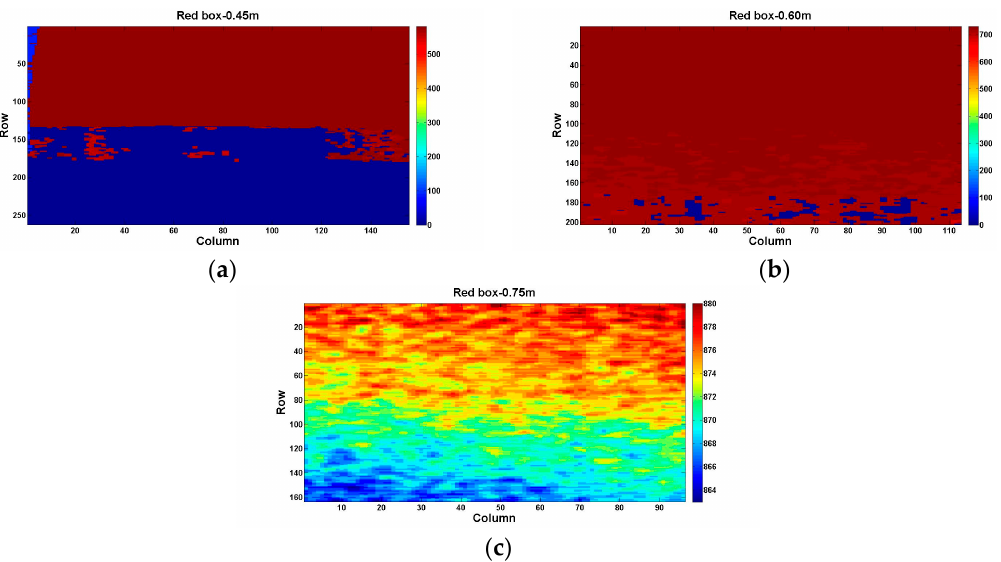
Figure 6. Visualized depth images of the red box region at different distances (front view): ( a ) 0.45 m; ( b ) 0.60 m; and ( c ) 0.75 m.